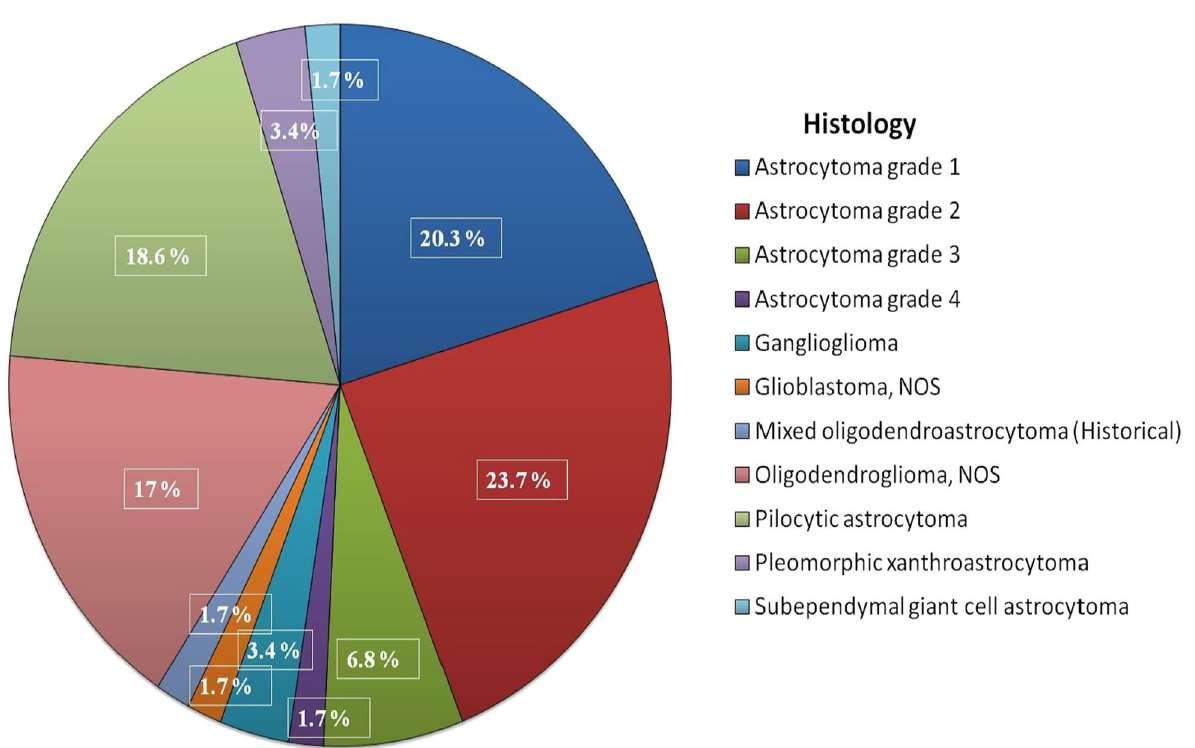
Fig. 2 Histological distribution of gliomas, glioneuronal tumors, and neuronal tumors in the pediatric